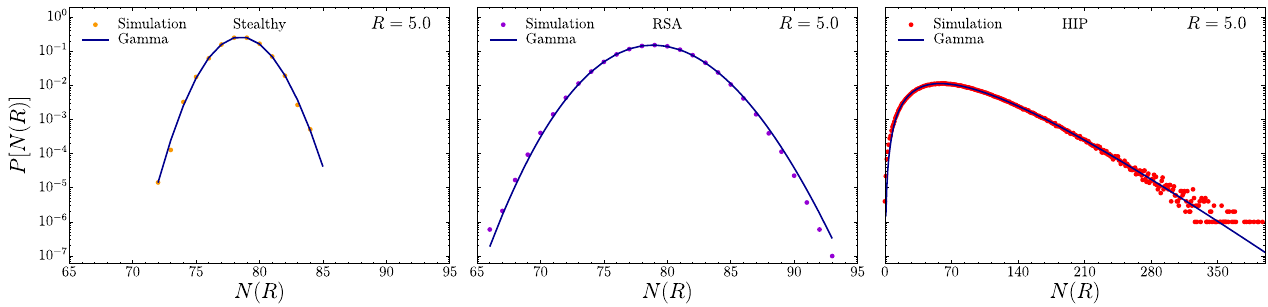
FIG. 6. Comparison of simulation data for the probability distributions P ½ N ð R Þ(cid:2) with R ¼ 5 for three 2D models (stealthy hyperuniform, RSA, and HIP) to corresponding gamma-distribution approximations with the same mean value and variance. The gamma distribution provides good approximations for all models that obey a CLTacross the first three dimensions considered, including the ones not shown